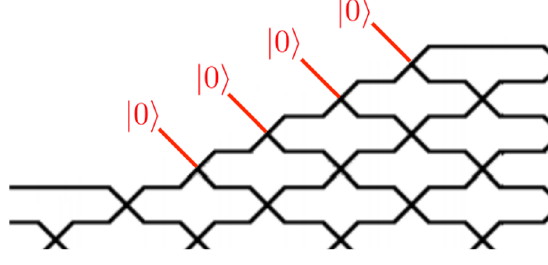
Figure 7 . An isometry of components make up the ‘shoulders’ on the Python’s lunch shown in (cid:12)gure 6, where the omitted.